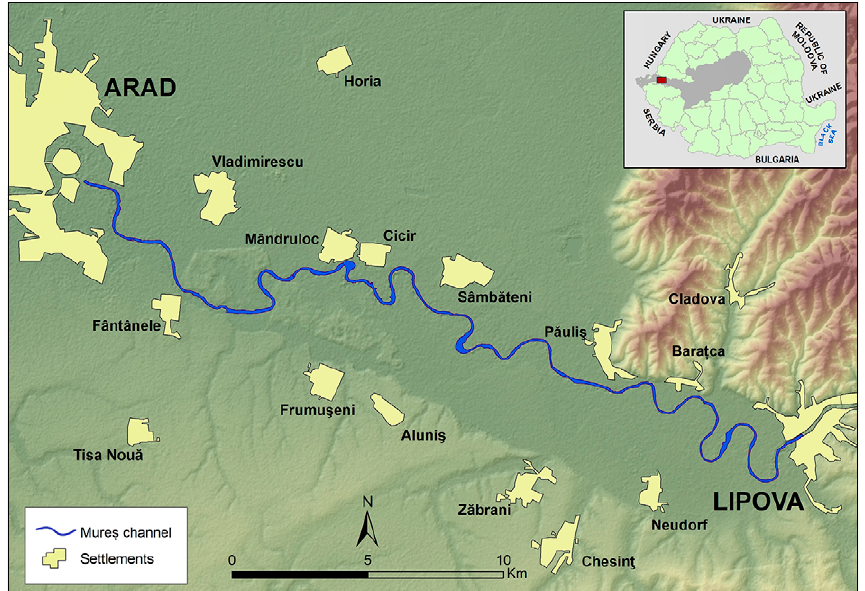
Figure 1. Location of the study